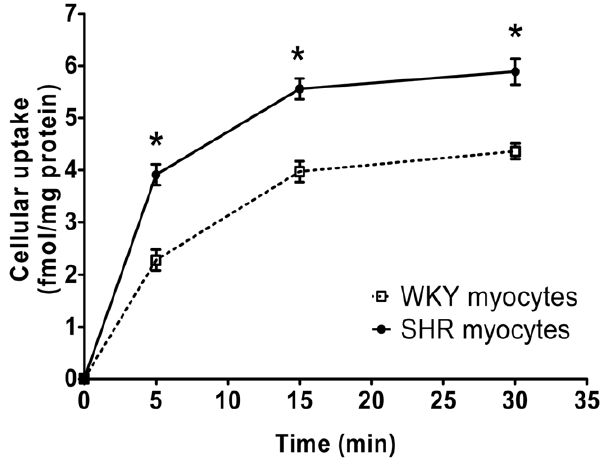
Figure 1. Uptake of Ang-(1–12) by neonatal cardiac myocytes. Time dependent increase in cellular uptake of 125 I-Ang-(1–12) in cultured neonatal SHR cardiac myocytes (solid line) as compared to WKY (dotted line) in the presence of all RAS enzymes inhibitors. Cellular internalization of 125 I-Ang-(1–12) is expressed as fmol 2 1 x mg 2 1 protein. Each value represents the mean 6 SE of three or more independent assays. In these experiments, WKY and SHR myocytes were treated with all inhibitor cocktail containing lisinopril (ACE inhibitor), SCH39370 (NEP inhibitor), MLN-4760 (ACE2 inhibitor), and chymostatin (chymase inhibitor), peptidase inhibitors (amastatin, bestatin & benzyl succinate), and PCMB each added at a dose of 10 m M. *Significantly different ( P , 0.001) from the mean of the corresponding time point of